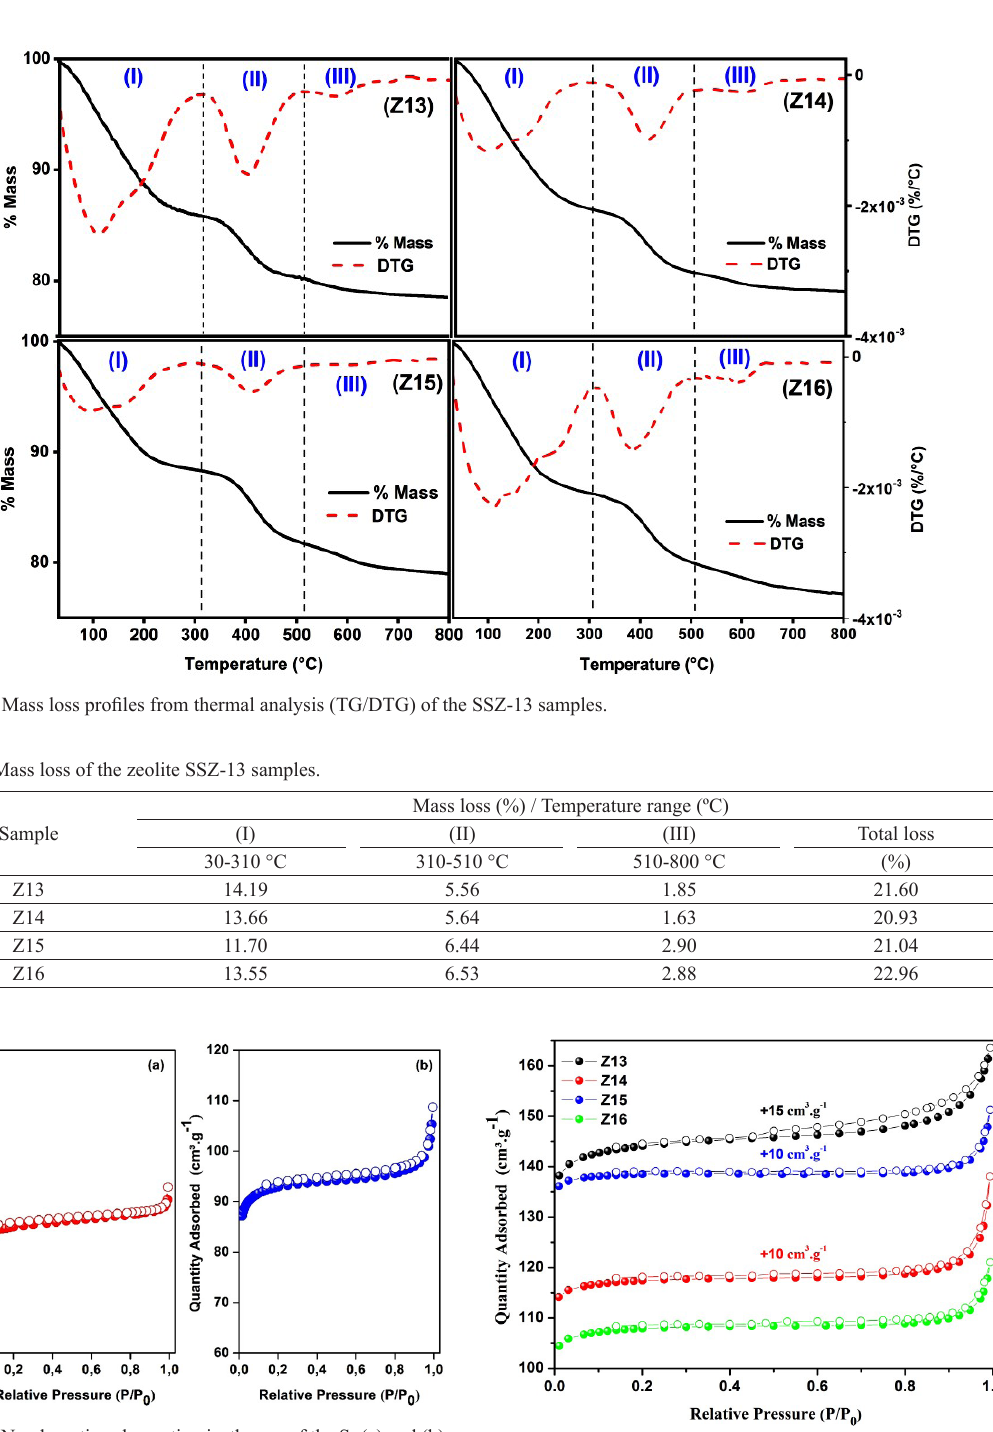
(a) and (b) 1 For clarity, the isotherms were offset along the y axis for Z14